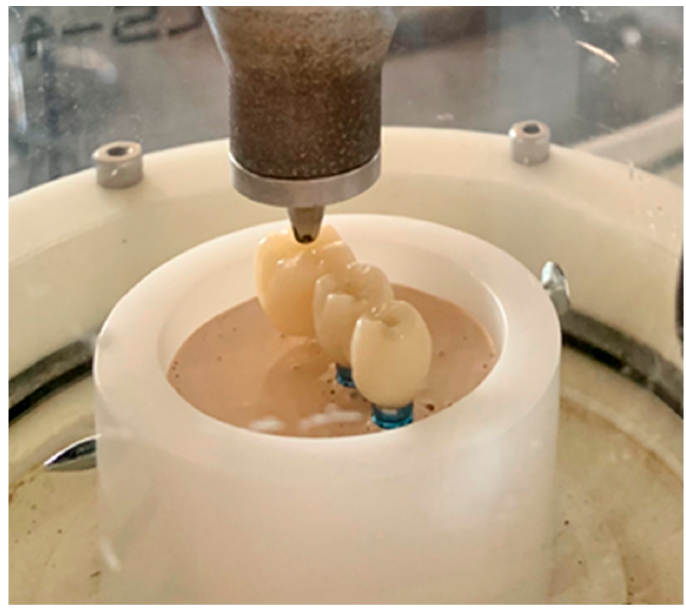
Figure 6. Study specimen mounted in the chewing simulator during fatigue testing.